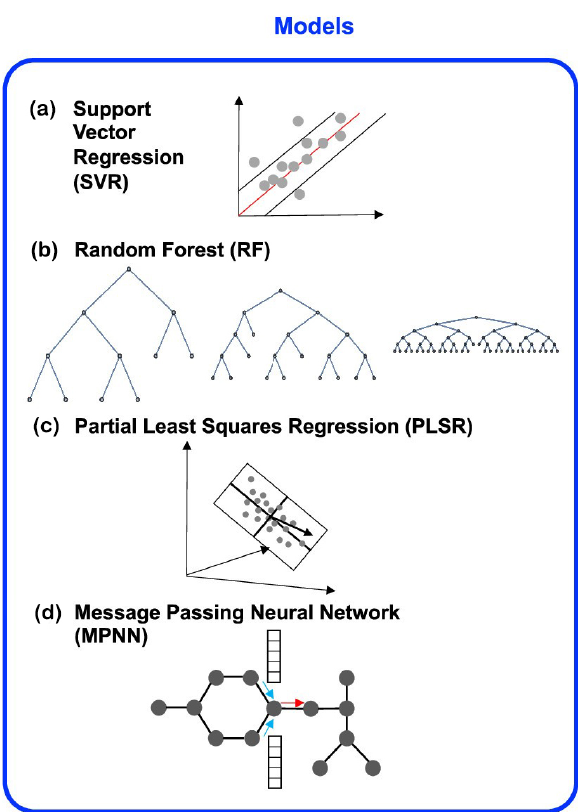
Figure 7. Overview of density regression models [24]. Copyright 2021 American Chemical Society.